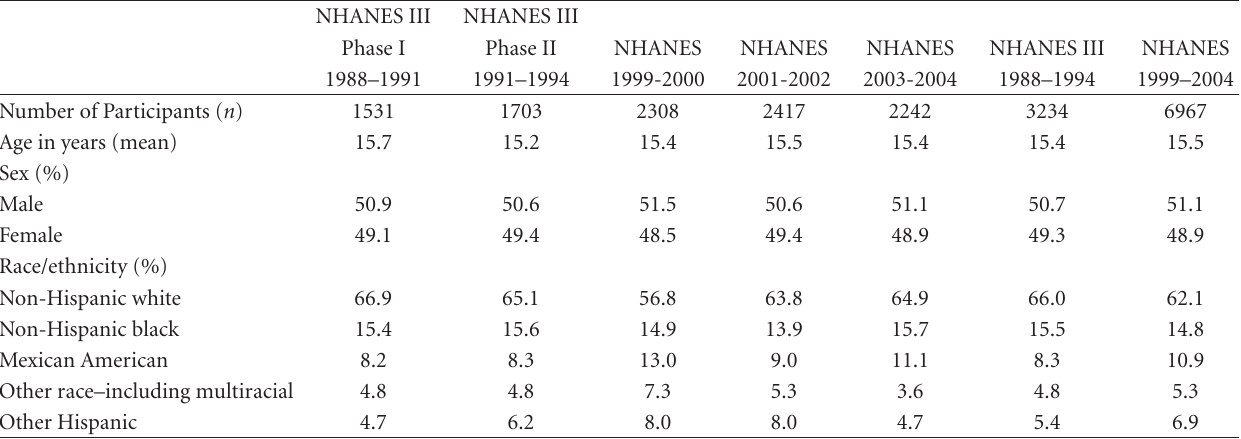
Table 1: Characteristics of US adolescents aged 12–19 years: NHANES III (1988–1994) and complete NHANES 1999–2004